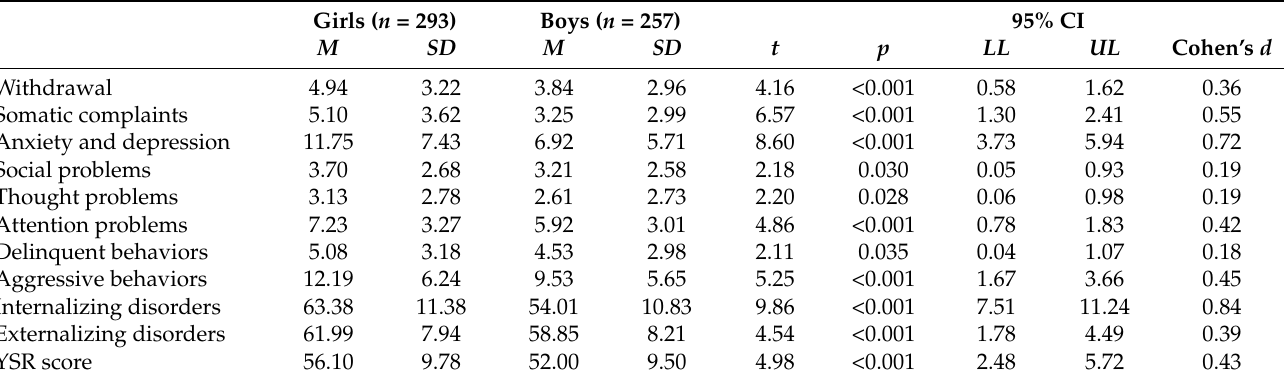
Student’s t test. The analysis showed statistically significant gender differences for all the analyzed scales. Girls reported more withdrawal, somatic complaints, anxiety and depression, social problems, thought problems, attention problems, delinquent behaviors, and aggressive behaviors, as well as internalizing and externalizing disorders, and higher YSR total scores than boys. The effect size for these differences was weak to moderate for somatic complaints and anxiety and depression, and strong for internalizing disorders. Greater emotional disinhibition and sensitivity to external stimuli in the girls’ sample may stem from the tendency to somatize the adolescent identity [50] or from stereotypical upbringing patterns which focus on reinforcing women’s emotionality and psychological fragility [51]. Detailed results of the analyses are shown in Table 3. Table 3. Youth Self Report scale scores in girls and